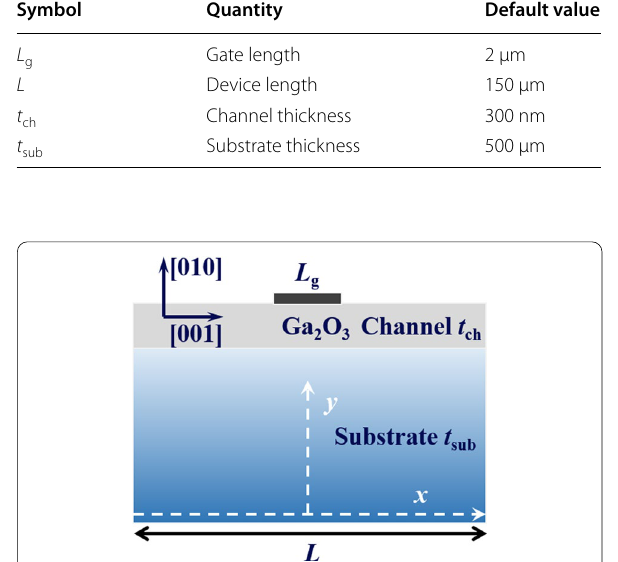
Fig. 1 The schematic diagram of Ga 2 O 3